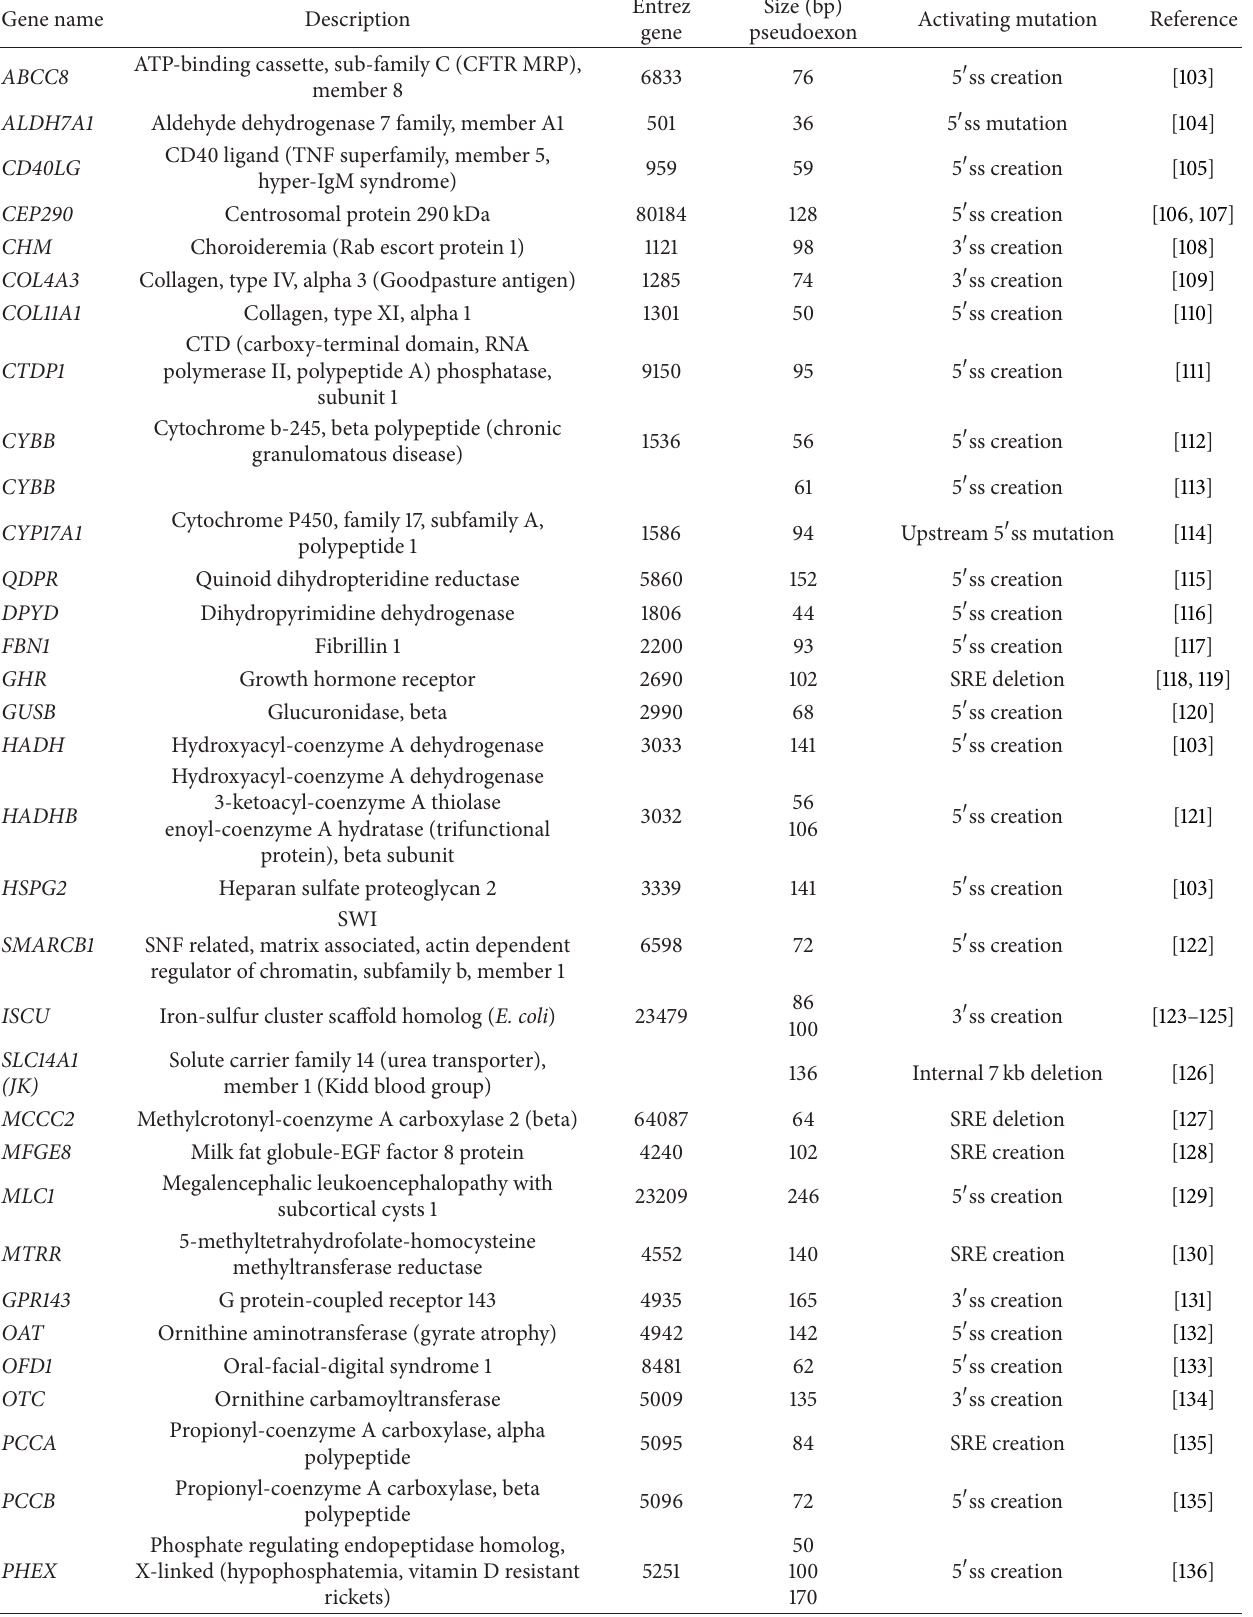
Table 3: Pseudoexons described in cancer-related